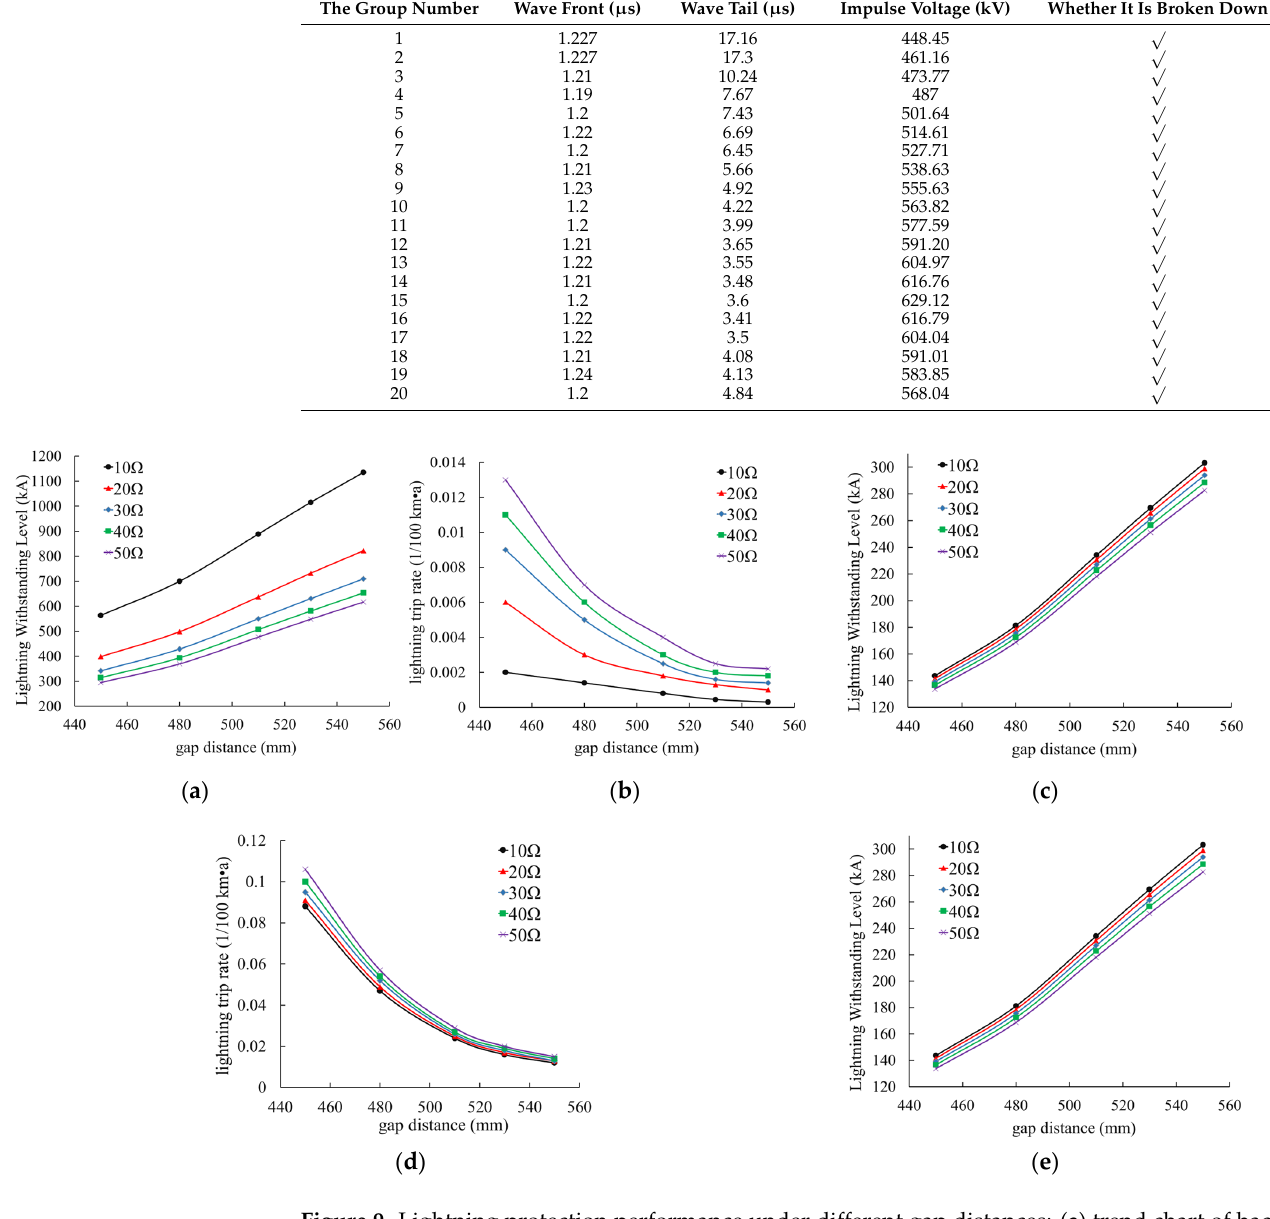
Table 5. The volt second characteristic of lightning impulse.